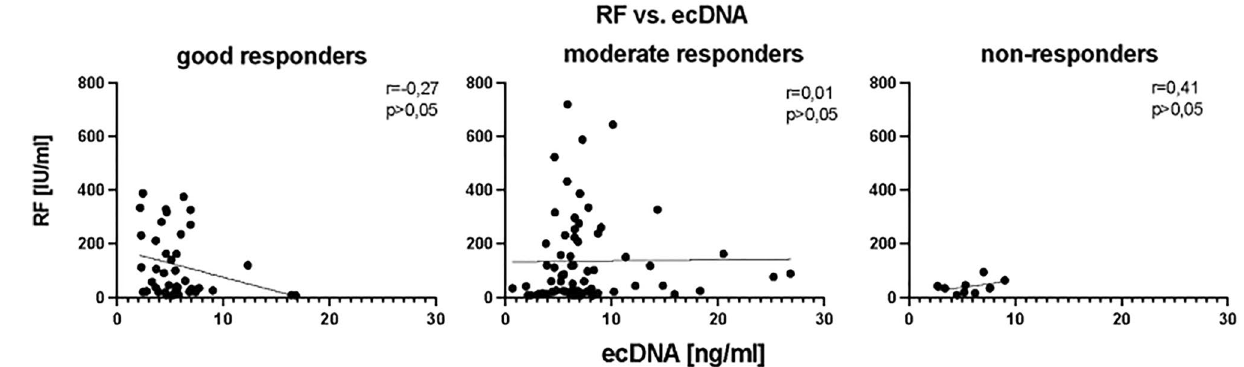
Figure 6. Correlations between concentration of the total baseline extracellular DNA (ecDNA) and rheumatoid factor (RF) in plasma of RA patients according to the treatment response.